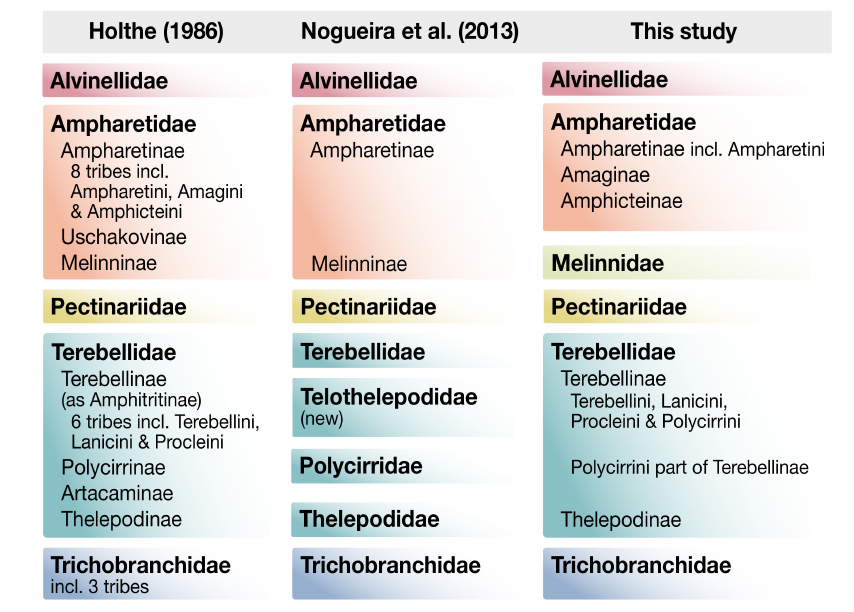
Figure 5. Summary of nomenclatural changes of this study in relation to two previous